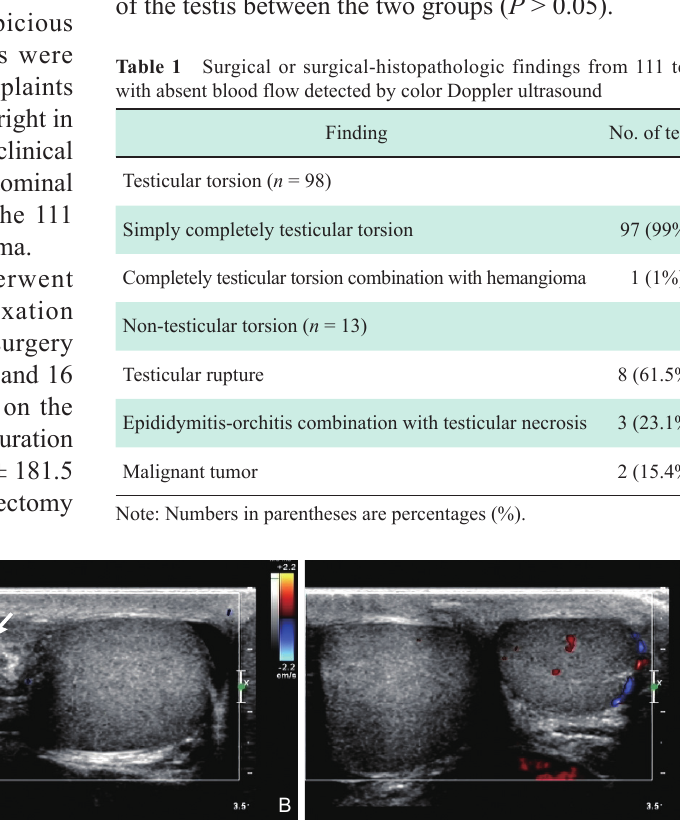
Figure 1 A twenty-five-year-old man had right-sided testicular torsion which was confirmed by surgery (testicular detorsion and fixation surgery). (A) CDU imaging in the longitudinal plane shows normal vascularization of the left testis; (B) CDU imaging in the longitudinal plane shows ABF in the right testis. The image also shows normal homogeneous echotexture of the right testis and whirlpool sign above the testis (arrows); (C) CDU imaging in the dual transverse plane shows ABF in the right testis (left) and normal vascularization of the left testis (right). The image also shows normal homogeneous echotexture in both